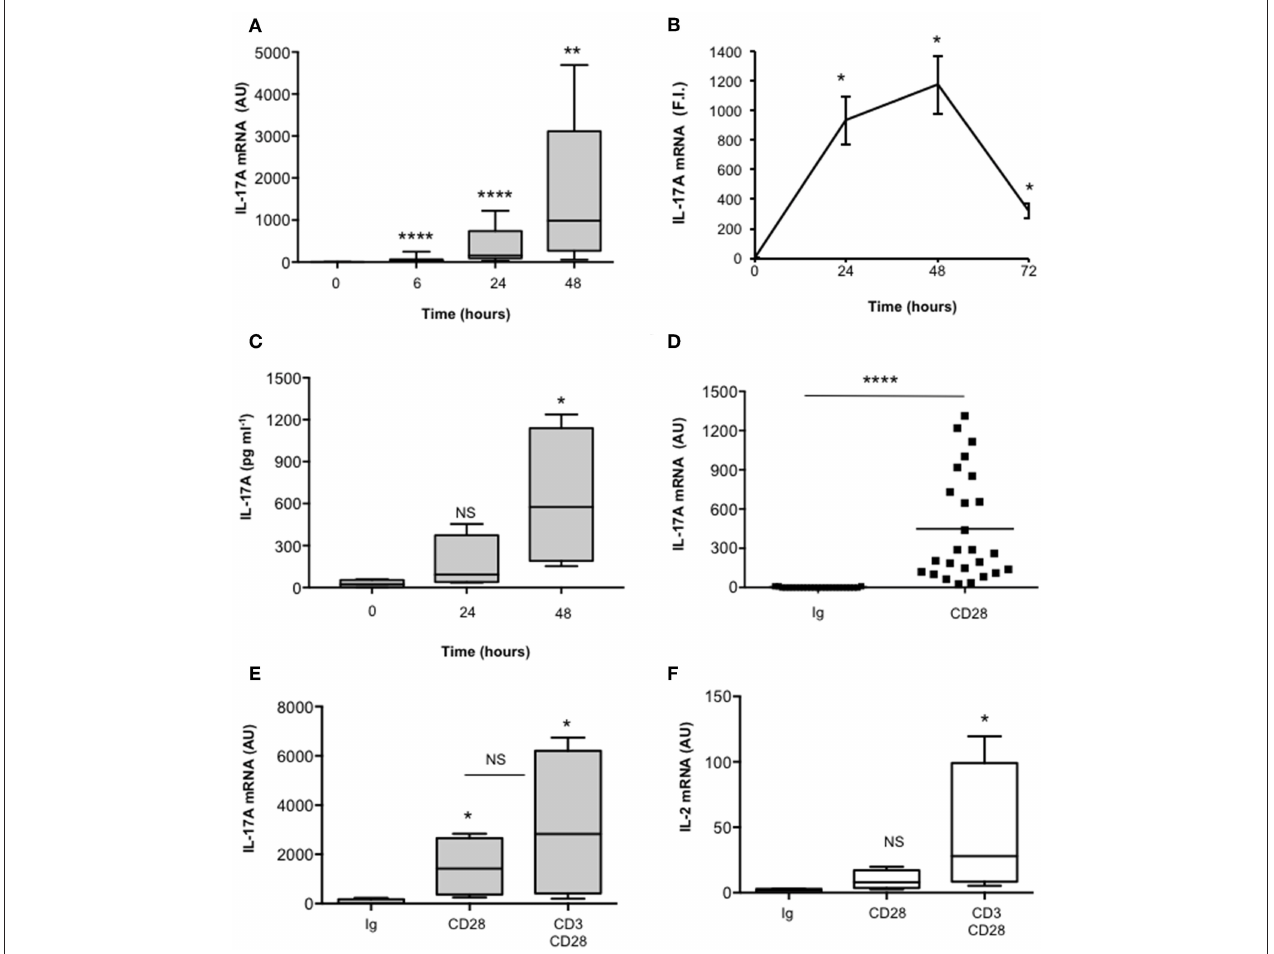
FIGURE 1 | CD28 stimulation up-regulates IL-17A gene expression and production. (A) CD4 + T cells from HD subjects ( n = 11) were stimulated for the indicated times with 2 µ g ml − 1 isotype control or anti-CD28.2 Abs. IL-17A mRNA levels were measured by real-time PCR and values, normalized to GAPDH, expressed as arbitrary units (AU). Lines represent median values and statistical significance was calculated by Mann-Whitney test. Median values: 0h = 1, 6h = 31, 24h = 154, 48h = 985. (B) IL-17A mRNA levels of CD4 + T cells stimulated for the indicated times with isotype control or anti-CD28.2 Abs. IL-17A mRNA levels were measured by real-time PCR and values, normalized to GAPDH, were expressed as fold inductions (F.I.) over the basal level of cells stimulated isotype control Ig. Data show the mean ± SD of one experiment representative of three. Statistical significance was calculated by Student t -test. (C) CD4 + T cells from HD subjects ( n = 4) were stimulated for 24 or 48h with isotype control or crosslinked anti-CD28.2 Abs. IL-17A levels in culture supernatant were measured by ELISA. Lines represent median values and statistical significance was calculated by Mann-Whitney test. Median values: 0h = 22 pg ml − 1 , 24h = 93 pg ml − 1 , 48h = 575 pg ml − 1 . (D) IL-17A mRNA levels of CD4 + T cells from HD subjects ( n = 25) stimulated for 24h with isotype control Ig or anti-CD28.2 Abs. Lines represent median values (AU) and statistical significance was calculated by Mann-Whitney test. Median values: Ig = 2.8, CD28 = 449. (E) IL-17A mRNA levels of CD4 + T cells from HD subjects ( n = 4) stimulated for 24h with isotype control Ig or anti-CD28.2 or anti-CD3 (UCHT1) plus anti-CD28.2 Abs. Lines represent median values (AU) and statistical significance was calculated by Mann-Whitney test. Median values: Ig = 8, CD28 = 1427, CD3/CD28 = 2823. (F) IL-2 mRNA levels of CD4 + T cells from HD subjects ( n = 4) stimulated for 24h with isotype control Ig or anti-CD28.2 or anti-CD3 (UCHT1) plus anti-CD28.2 Abs. Lines represent median values (AU) and statistical significance was calculated by Mann-Whitney test. Median values: Ig = 1.7, CD28 = 8, CD3/CD28 = 28. * p < 0.05, ** p < 0.01, **** p < 0.0001, calculated on cells stimulated with isotype control